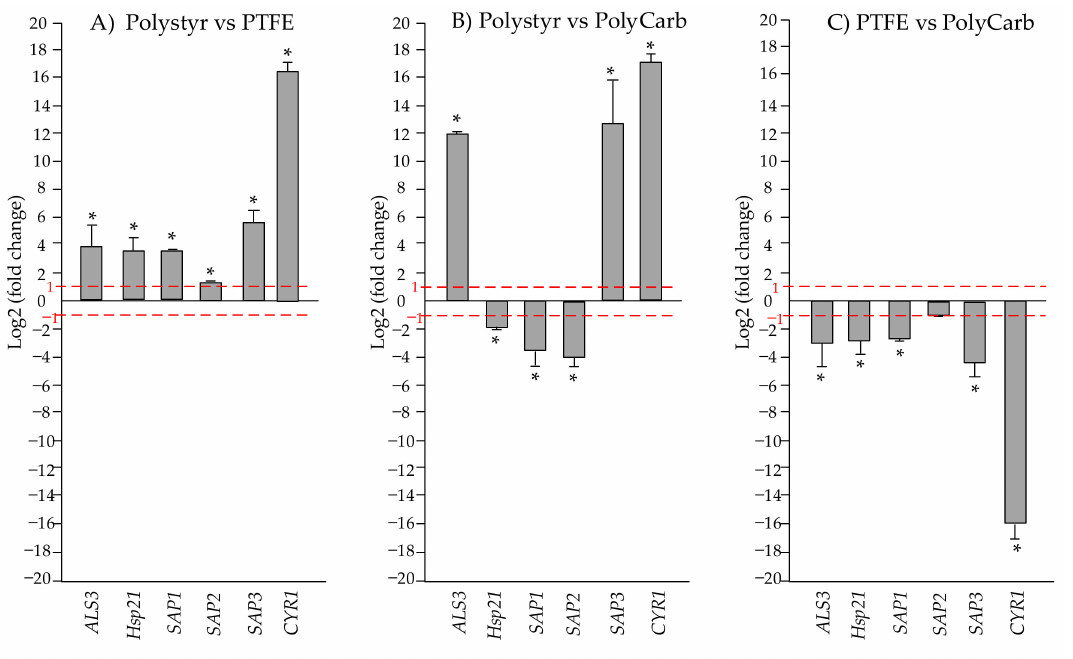
Figure 10. Mean relative mRNA expression levels of virulence and stress response genes of C. tropicalis DSM 11951. ( A ) polystyrene vs. polytetrafluoroethylene (PTFE); ( B ) polystyrene vs. polycarbonate; ( C ) PTFE vs. polycarbonate. Fold change was calculated according to the formula fold change = 2 − ∆∆ Ct by using Ct (threshold cycle number) generated by the qRT-PCR system. Reported fold changes are the means of three replicate experiments. Fold changes significantly different from 1 ( p value < 0.05) are marked by an asterisk. Red broken lines indicate fold change thresholds of 2.0 and 0.5,